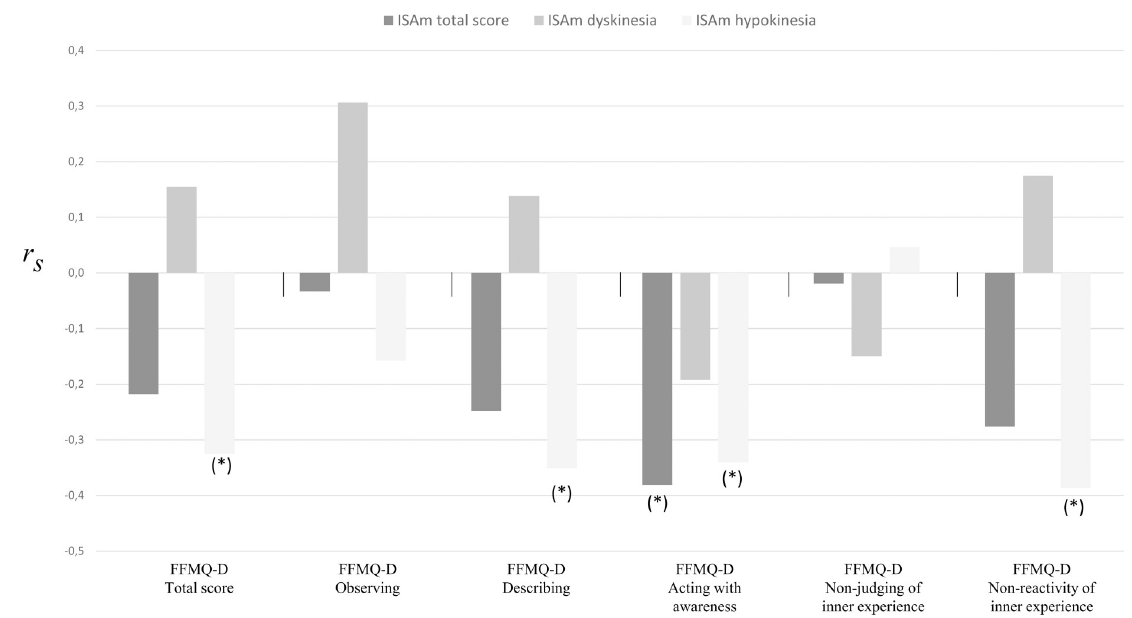
Fig 4. Spearman correlations between ISAm and FFMQ-D scores. Abbreviations: FFMQ-D, Five Facet Mindfulness Questionnaire– German version; � p < .05.